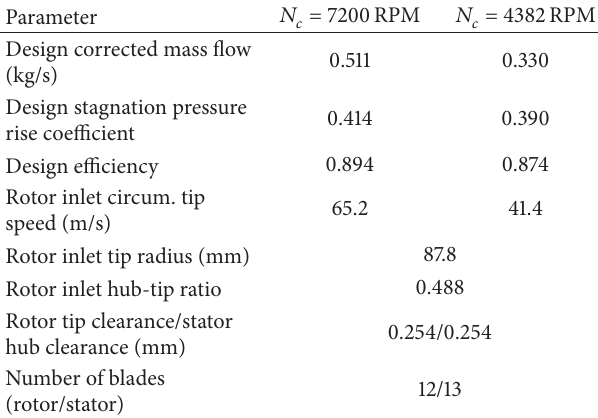
Figure 5: Radial and radial-circumferential traverse designs. Table 1: Design parameters of the axial compressor stage.